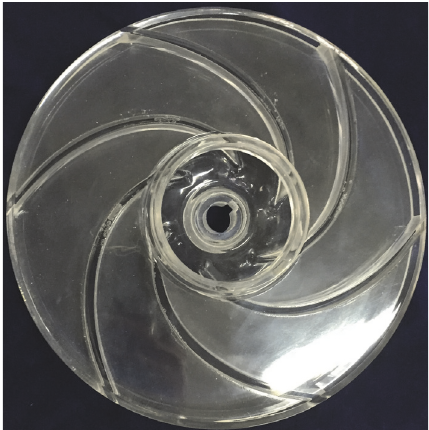
Figure 3: The transparent impeller made of Plexiglass for cavitation